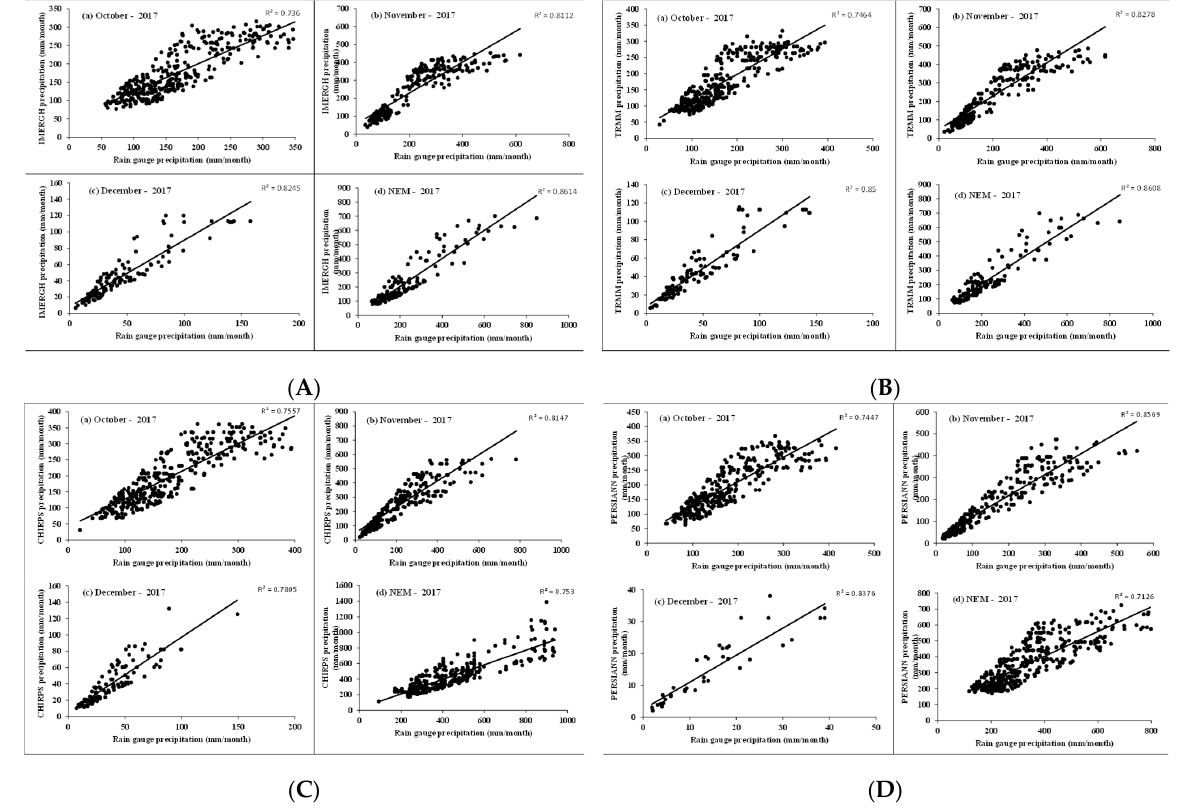
Figure 10. Sca tt er plots of monthly and accumulated rainfall for the year 2017 from rain-gauge stations vs. ( A ) IMERGH, ( B ) TRMM, ( C ) CHIRPS, ( D ) PERSIANN at the point-based station.